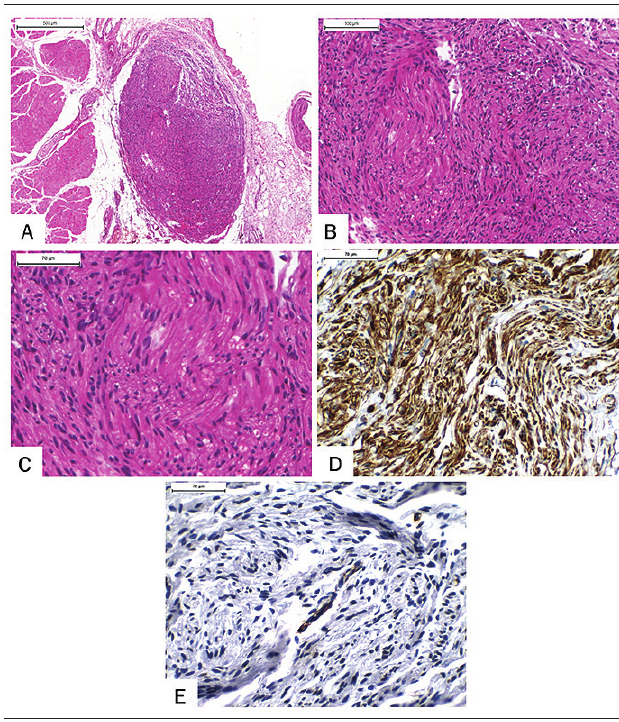
figurE 2 − Histopathological and immunohistochemical aspects A) well-circumscribed spindle-cell lesion located in deep planes; B) proliferation of spindle- shaped and ovoid cells organized in short fascicles, sometimes forming a rudimentary palisading arrangement; C) detail of neoplastic cells, highlighting well-stained wavy nuclei, with imperceptible nucleoli; D) immunohistochemical analysis revealing intense and diffuse positivity for S-100 protein; E) positivity just focal and limited to the wall of small vessels for α -SMA. α -SMA: alpha-smooth muscle